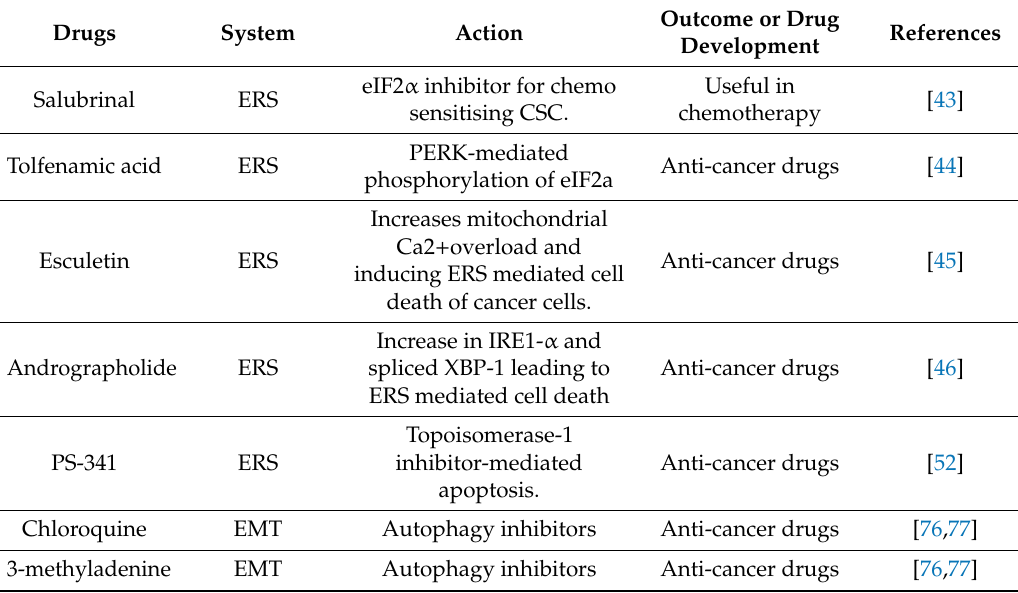
Table 2. Anti-cancer agents developed from ERS and